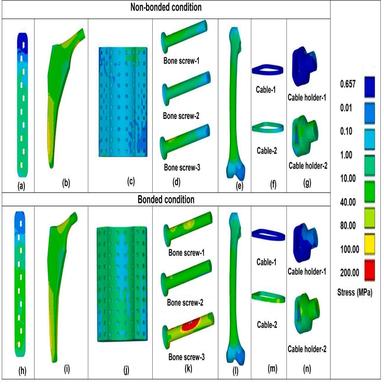
The equivalent stress distribution in the (a) plate, (b) femoral implant, (c) AMTD, (d) bone screws, (e) femur, (f) cables, (g) cable holders for non-bonded and (h) plate, (i) femoral implant, (j) scaffold device, (k) bone screws, (l) femur, (m) cables, (n) cable holders for bonded conditions of the FE model subjected to the static load of 860 N.